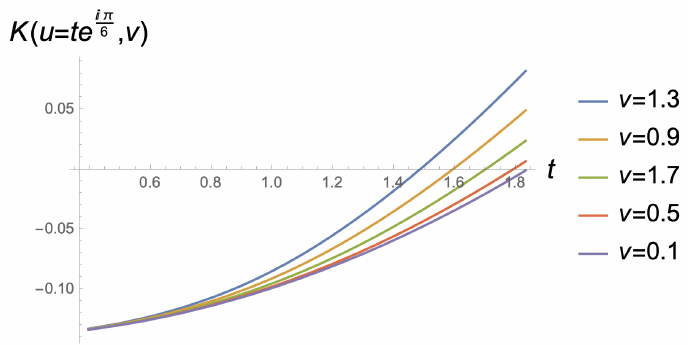
(a) K plotted along rays parameterized by u = te iπ 6 , for various real values of v . Each ray consists of 100 data points. As v is increased, the region of negative K shrinks.